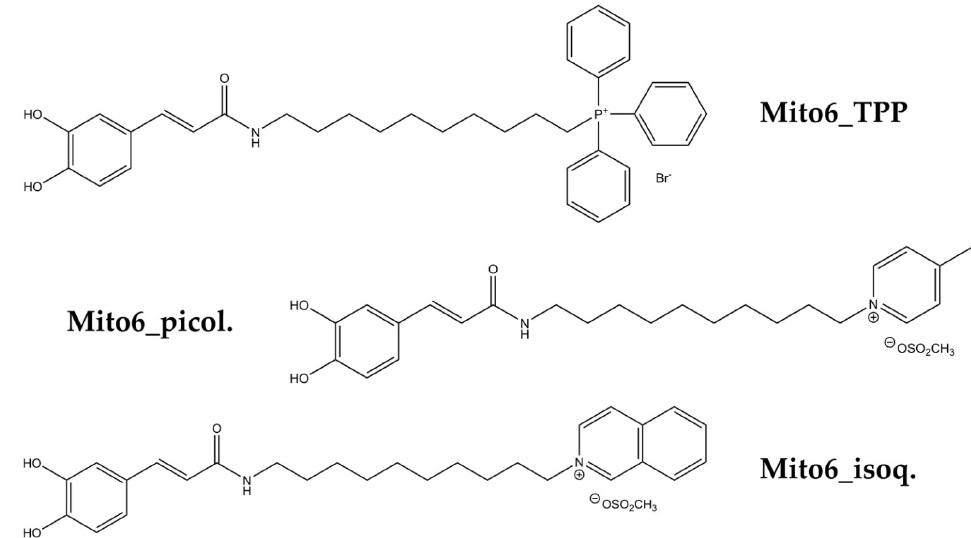
Figure 2. Chemical structures of mitochondria-targeted antioxidants used in this